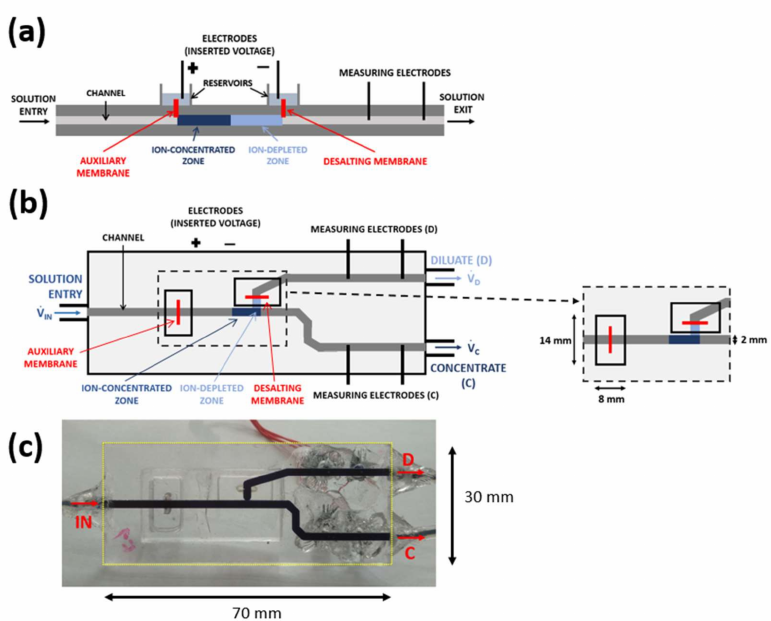
Figure 6. ( a ) Schematics of the microfluidic chip designed for continuous ICP-based desalination/preconcentration—side-view, ( b ) schematics of the microfluidic chip—top-view, ( c ) the picture of the completed microfluidic chip filled with a solution of trypan blue for an easier view of the channel